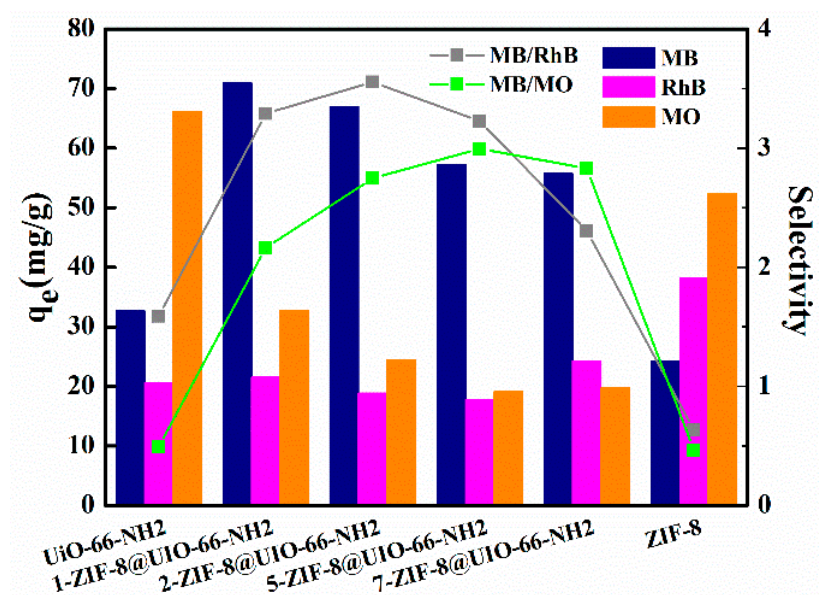
ff erent adsorbents in mixed